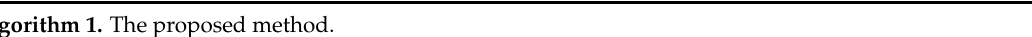
Algorithm 1. The proposed